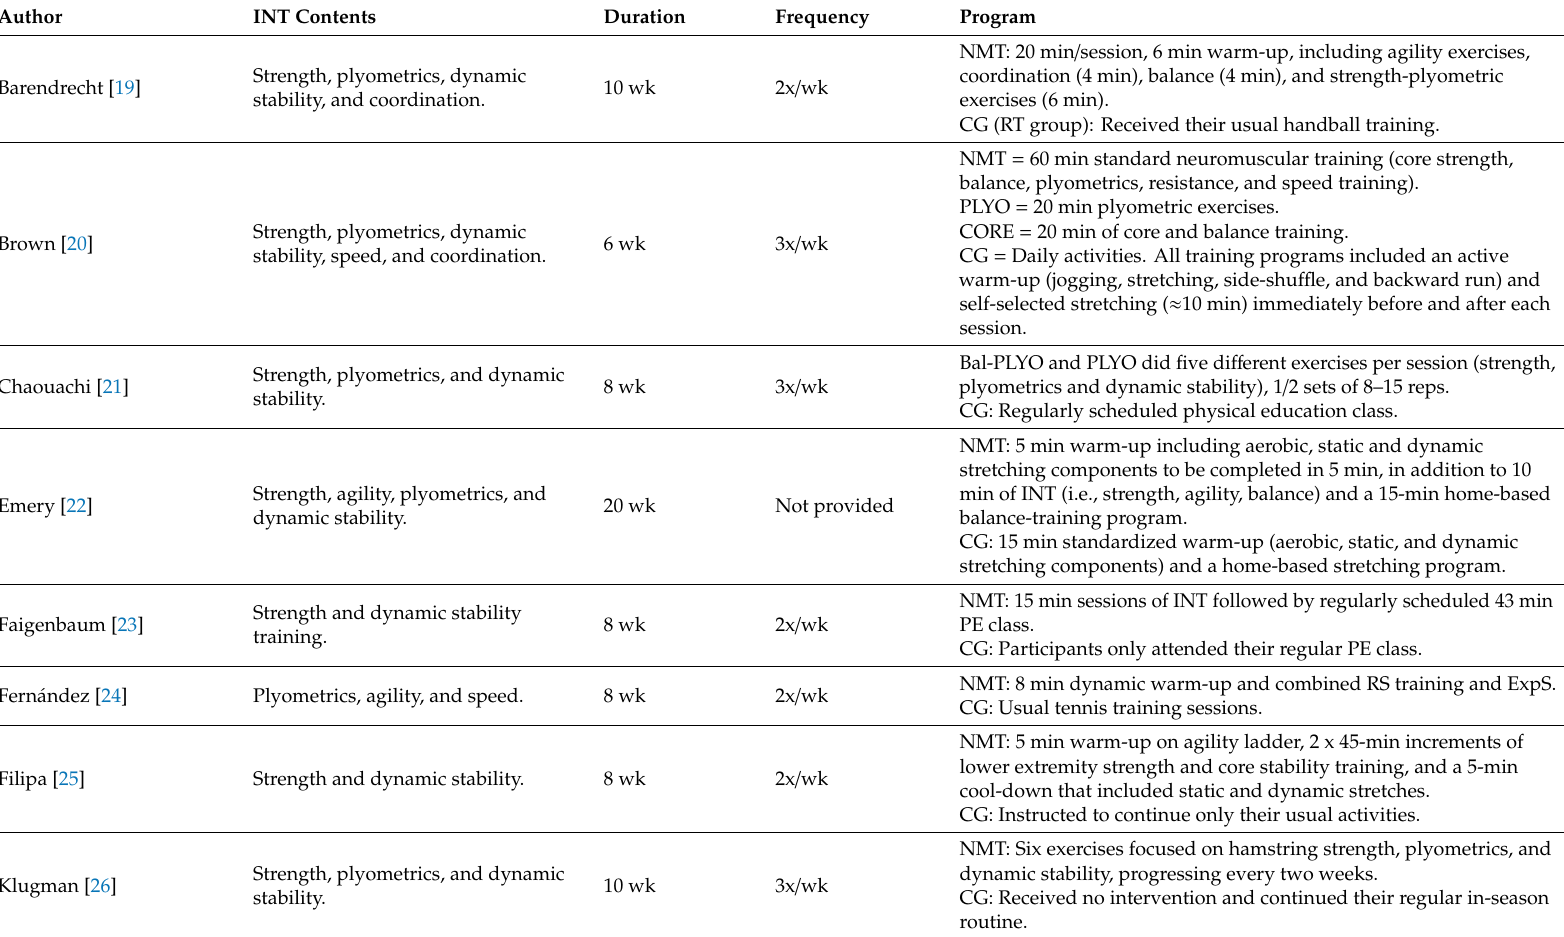
Table 3. Characteristics of the intervention